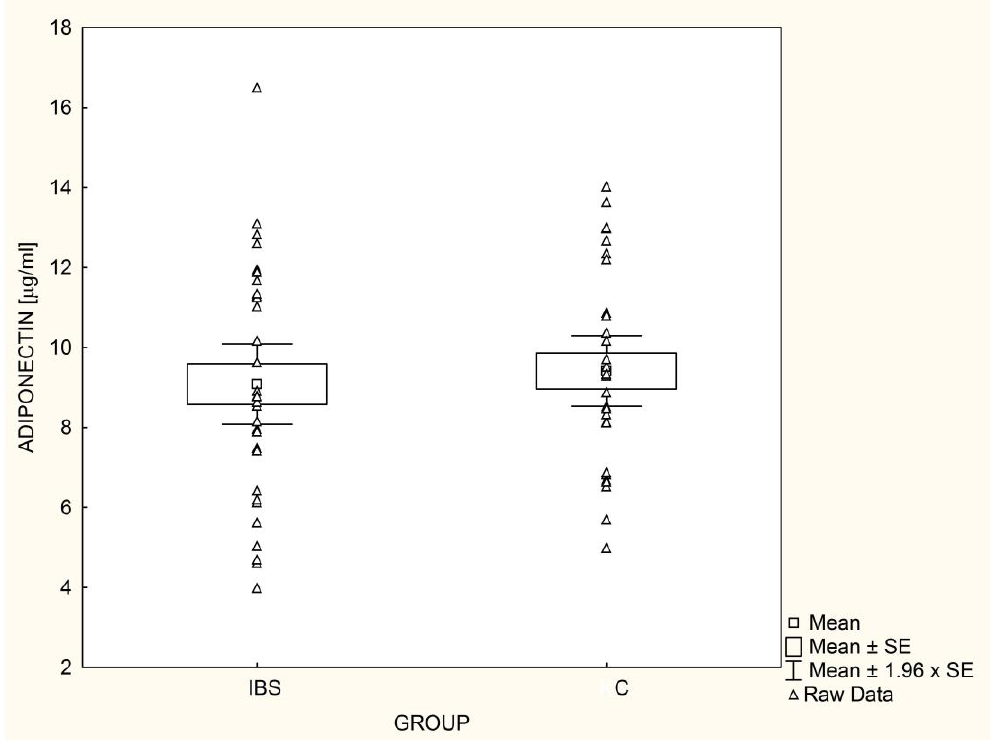
Figure 2. Mean adiponectin levels in children with irritable bowel syndrome (IBS; n = 33) and controls (C; n = 30).